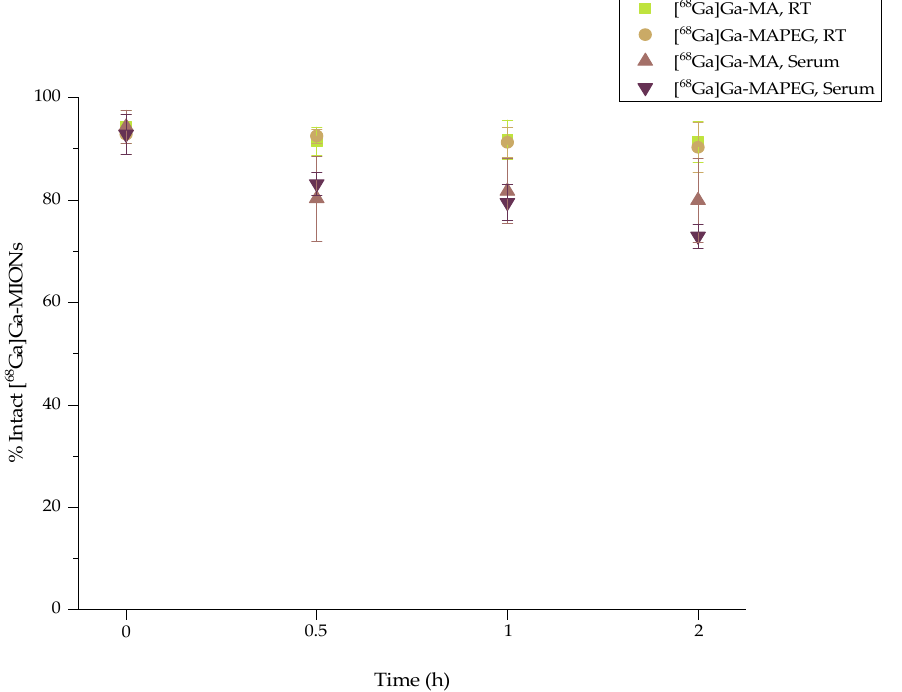
Figure 4. Radiochemical stability of [ 68 Ga]Ga-MA and [ 68 Ga]Ga-MAPEG at RT and in human serum (x axis not in